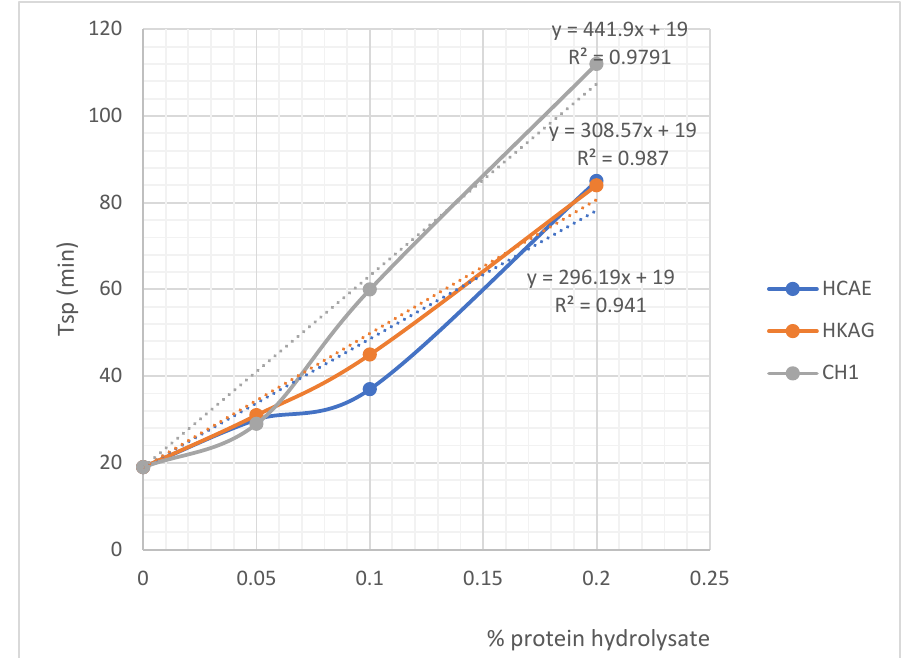
Figure 8. Variation of final time for plaster setting as a function of protein hydrolysate concentration. Dotted lines represent a linear estimation of final setting time as a function of hydrolysates dosage w/w. For the case when no hydrolysates were used, initial and final setting time is for gypsum plaster alone (19 min).